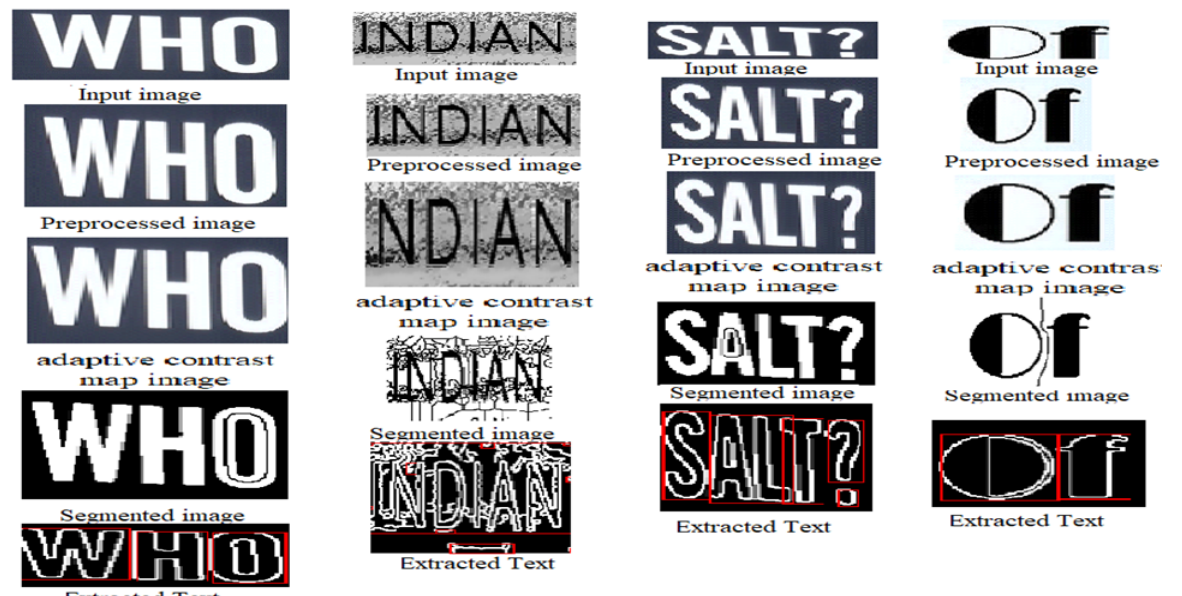
Figure 7. Extracted textual images after applying DNN and PSO on four different input textual